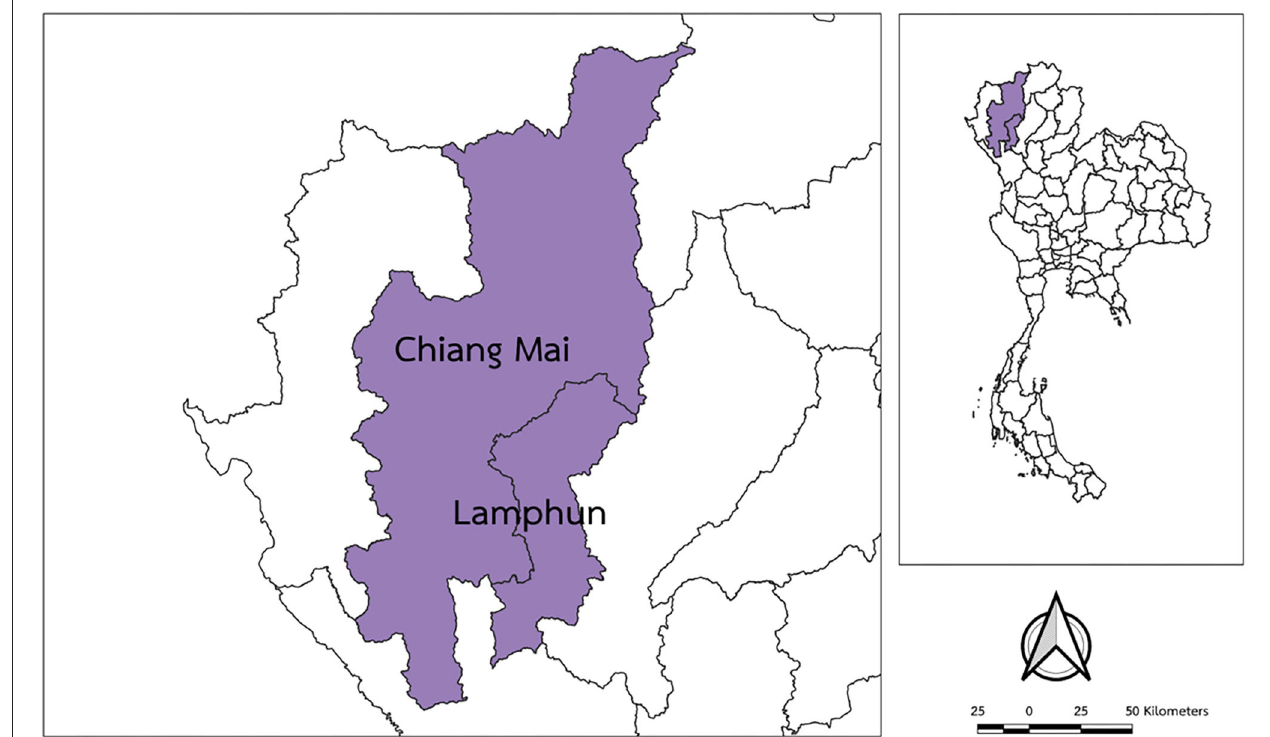
FIGURE 1 | Geographical map of Chiang Mai and Lamphun provinces in northern